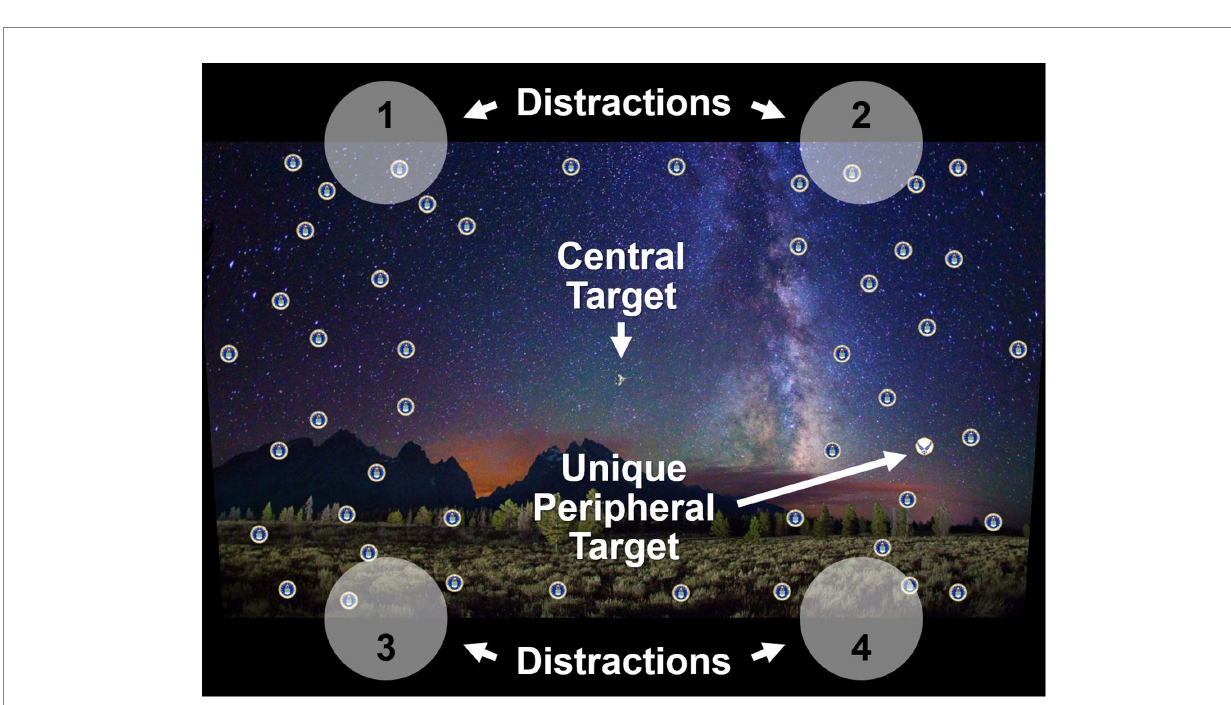
FIGURE 2 Visual scene shown to the participant, with overlaid annotations to highlight the central target, the unique peripheral target, and the location of the bright-light distractions (1 to 4). Adapted with permission from